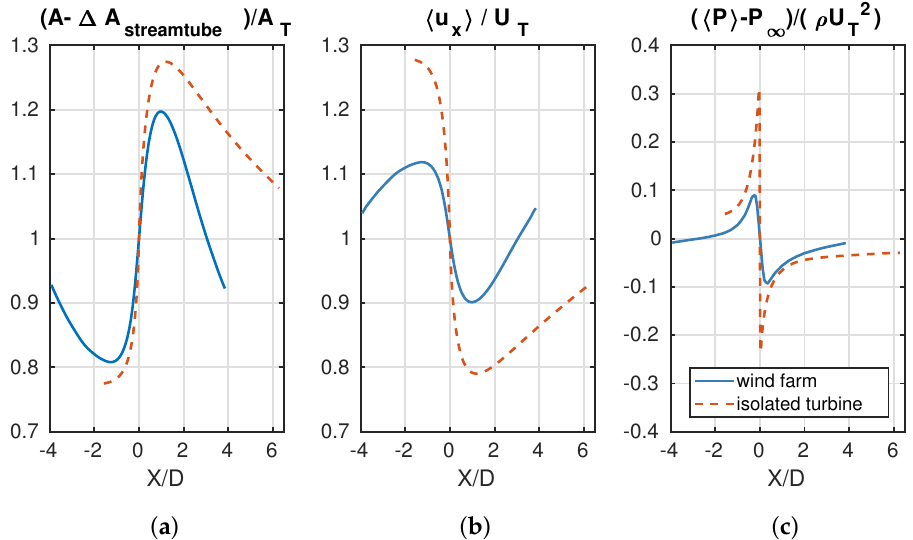
= 1.33. T because in the 0